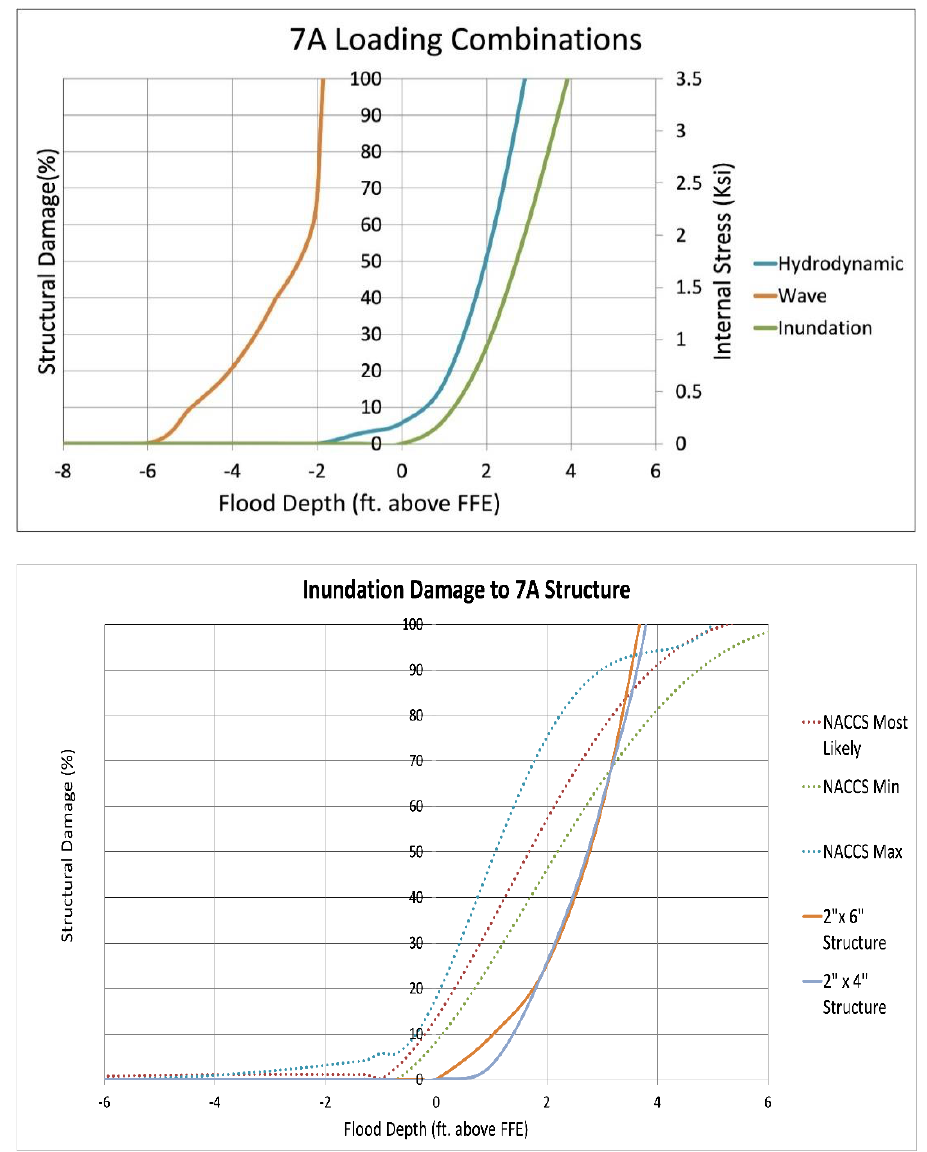
Figure 17. Structural damage based on wave, inundation, and hydrodynamic loads vs. flood depth relative to FFE for an open pile supported structure (Type 7A) (upper panel), and structural inundation damage for a 2 in × 4 in and 2 in × 6 in studded structure vs. flood depth compared to the NACCS [8] minimum, most likely, and maximum damage curves (lower panel). The internal stress (ksi) is shown on the right vertical